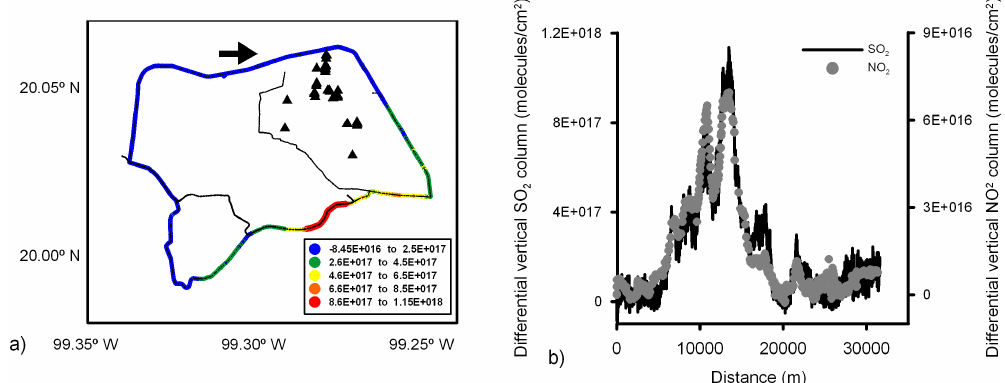
Fig. 3. Typical measurement at Tula industrial complex performed on 26 March 2006 between 14:18 and 15:03 local time. Panel (a) presents the spatial distribution of differential SO 2 columns (color coded) quantified during the measurement, whereas panel (b) shows variation in differential vertical SO 2 (black) and NO 2 (grey) columns for the measurement as function of travelled distance. The arrow in panel (a) shows the starting point of the measurement and points towards the direction of travel.